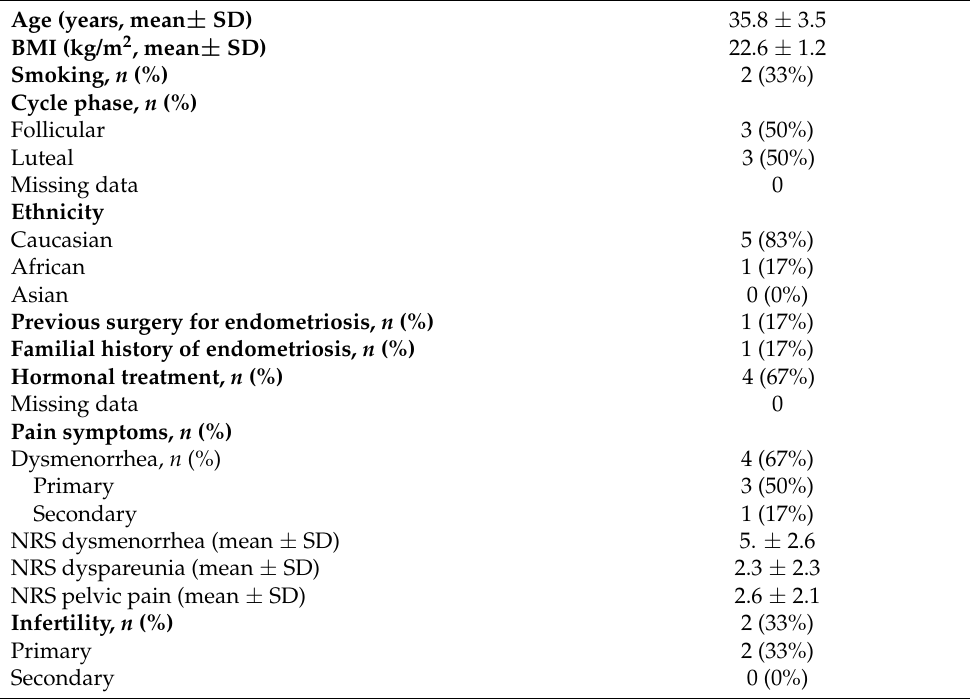
Table 2. Clinical characteristics of the study population selected for immunohistochemistry assays: n = 6 patients with endometriosis (OMA). NRS: Numerical Rating Scale. BMI: body mass index. SD: standard deviation.